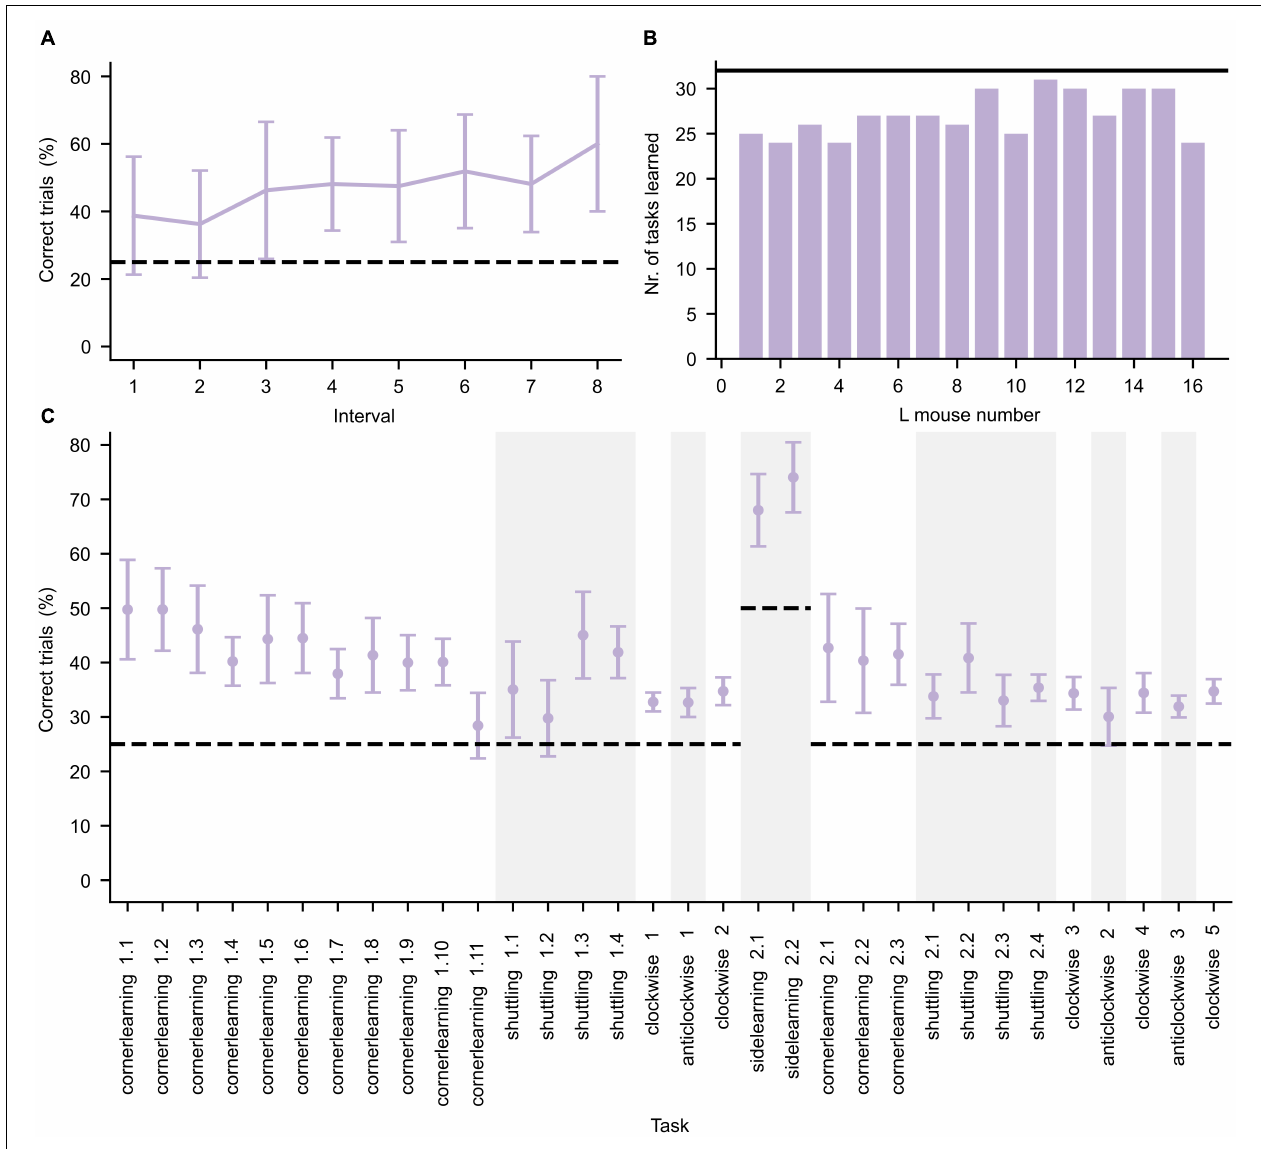
FIGURE 3 | Performance during the first IntelliCage phase. (A) Average performance ( ± standard deviation, n = 16) of all L mice for the first day of the cornerlearning task, divided in intervals of 10 trials per interval. Since the least active mouse performed less than 90 trials, only the first eight intervals are shown. The increase of performance over time reflects learning in the mice. (B) Number of tasks for which the L mice successfully achieved the learning criterion. The black horizontal line represents the total number of tasks. (C) Average performance ( ± standard deviation, n = 16) per learning task. Changes in task type are separated by alternating white and gray background color. The learning tasks are represented in chronological order. The dashed lines in panels (A,C) represent the chance level of correct performance in each